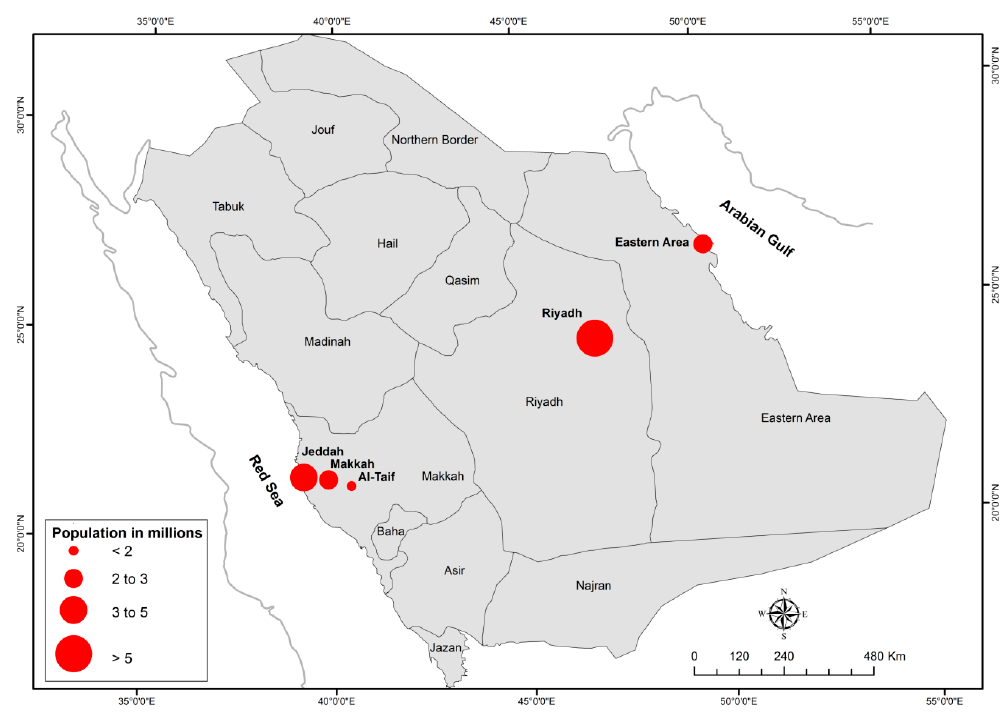
Figure 1. Geographical locations with the estimation of population of 2015 (in millions) of the selected study sites in Saudi Arabia. Table 1. The 2015 population and importance of the five cities.